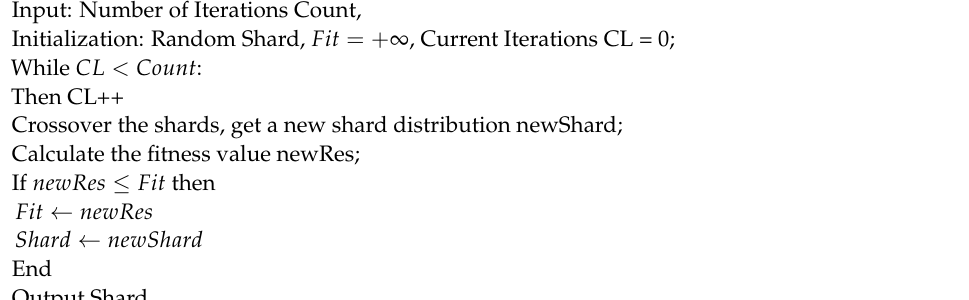
Algorithm 1: Node cross reconstruction sharding scheme based on reputation.